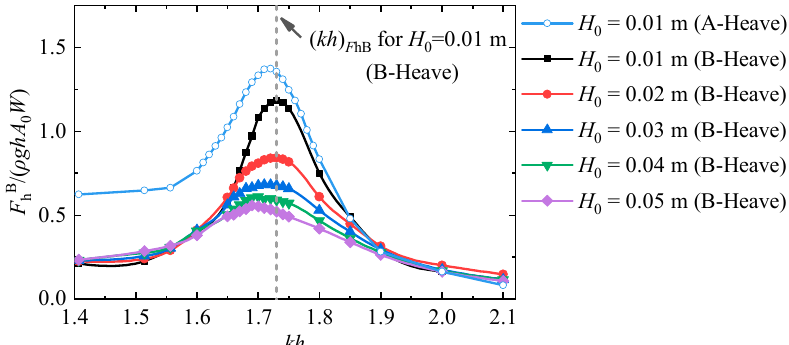
Figure 7. As in Figure 4, but for the normalized horizontal wave force on Box B.